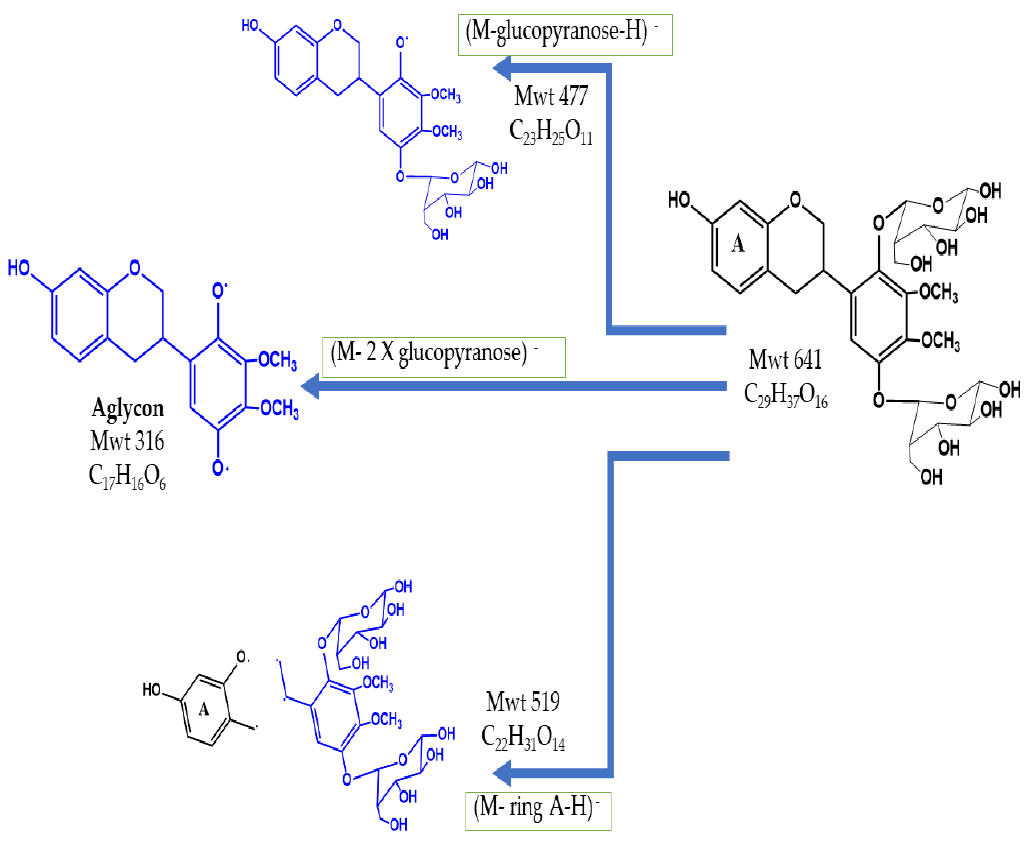
Figure 2. The structure and fragmentation of 5–hydroxy isomucronulatol–2 ′ ,5 ′ –di– O –glucoside.